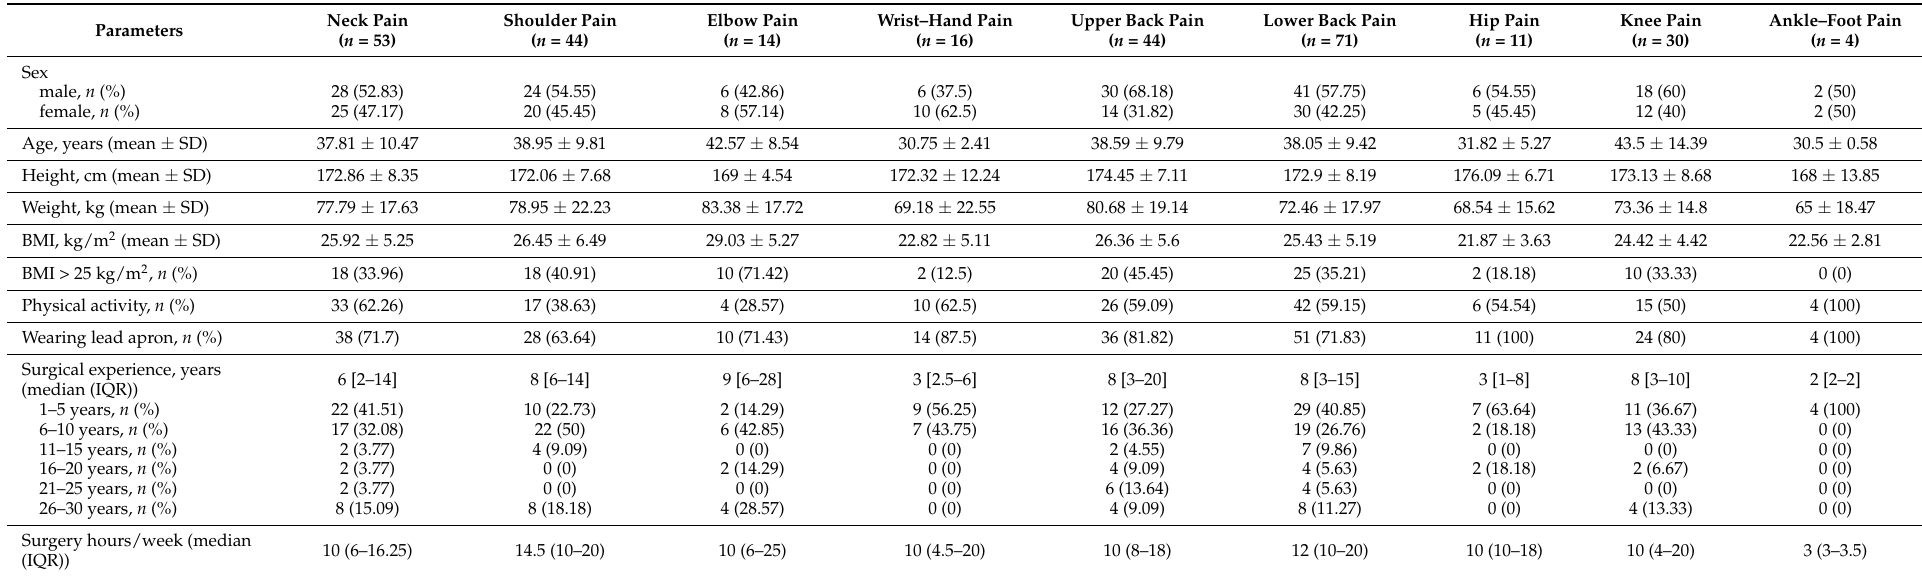
Table 2. Subjects’ characteristics related to the affected region.